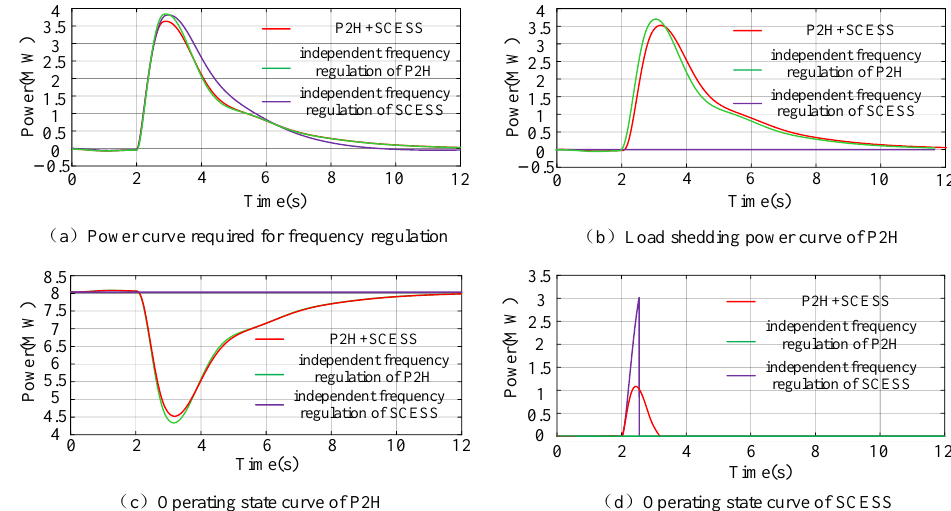
Figure 28. Frequency regulation dependent power curve.